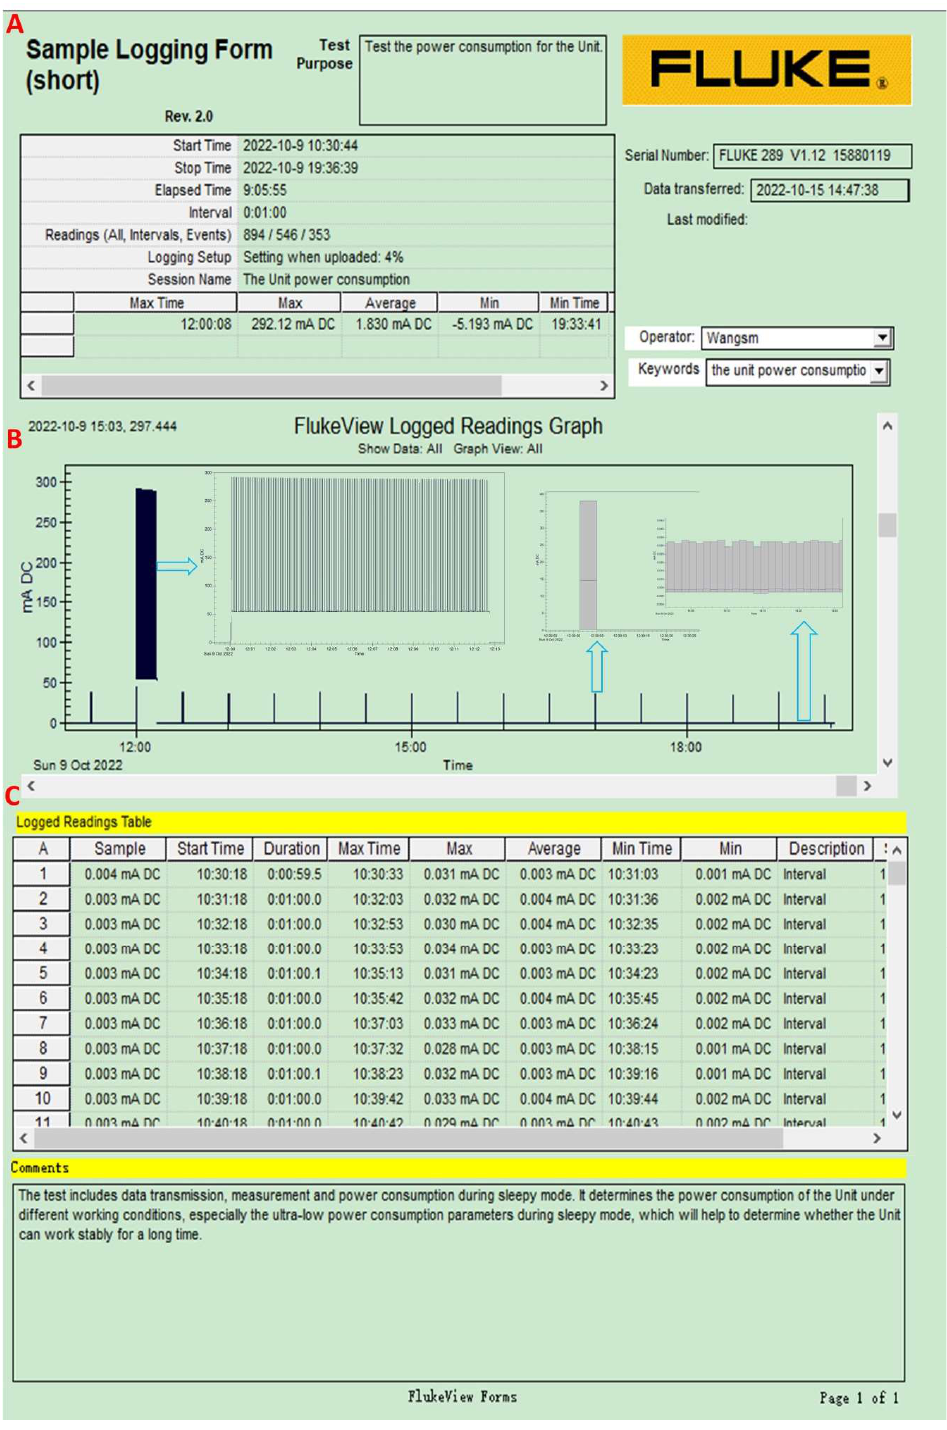
Figure 6. Power consumption measurement for the glacier internal measurement unit, including the logging descriptions ( A , upper panel), FlukeView GRAPH ( B , middle panel), and the detailed data ( C , bottom panel). The black wide thick bar, the black thin bars, and the horizontal line between the two black thin bars refer to the power consumption when the unit sending measurement data within a day at a set time (12:00 a.m.), the measuring data, and when it functions in the sleep mode, respectively. Details are shown in the inner corresponding